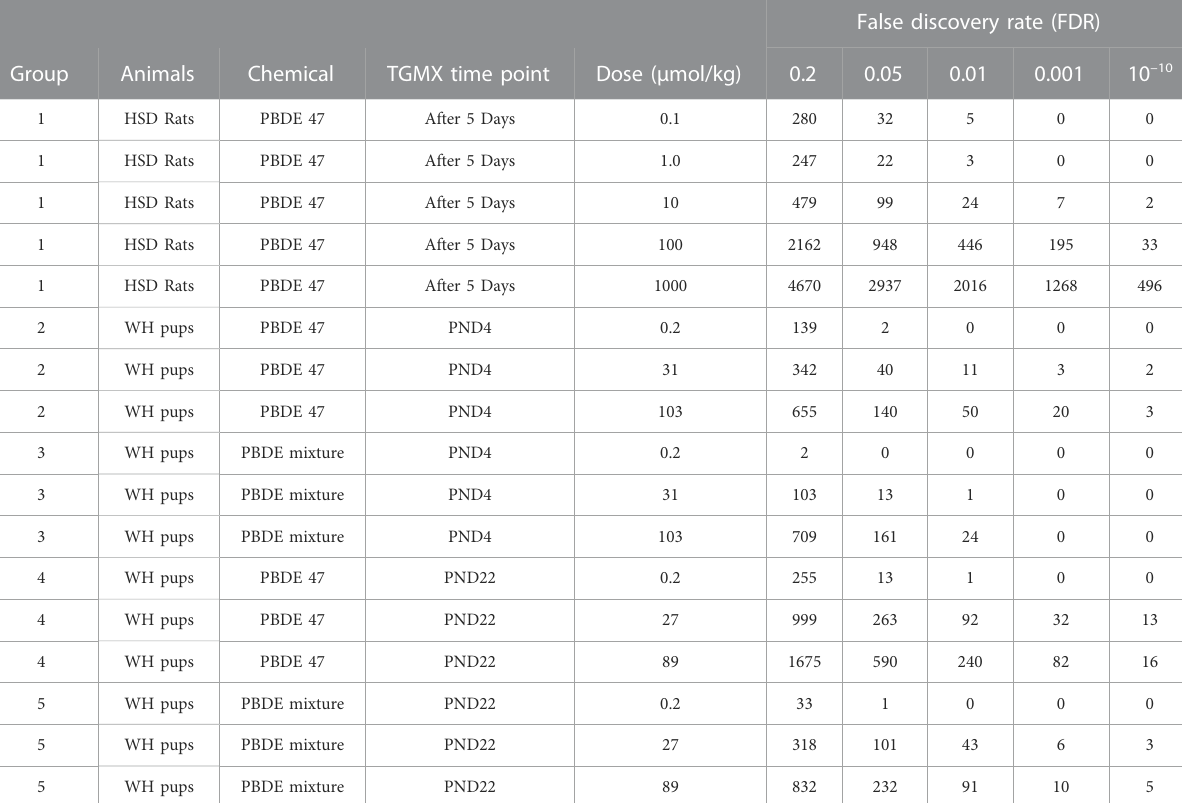
TABLE 2 Number of signi fi cant transcripts induced in the liver by pentabrominated diphenyl ether (PBDE) or PBDE mixture